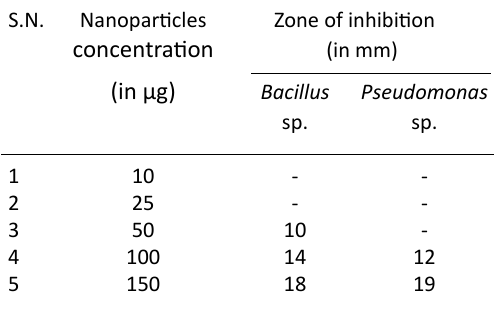
Table 1. Antibacterial activity of chitosan nanoparticles against food spoilage pathogens Bacillus sp. and Pseudomonas sp.